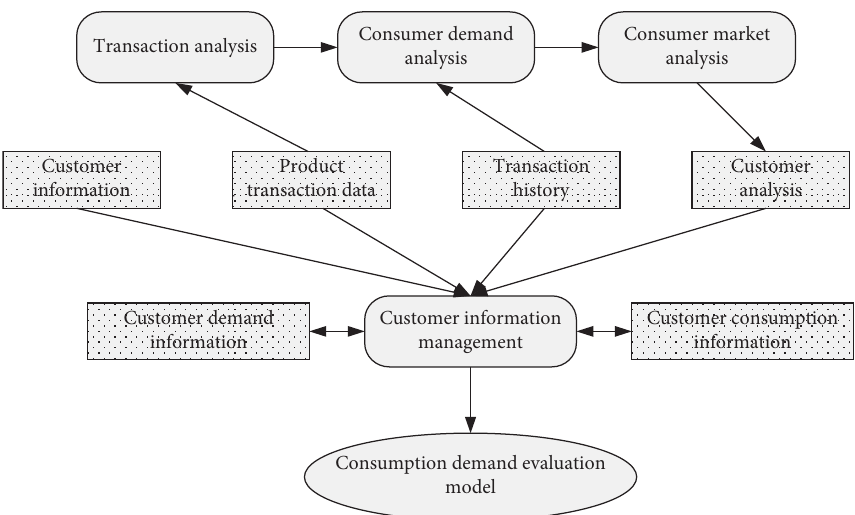
Figure 4: Construction process of the consumption demand evaluation